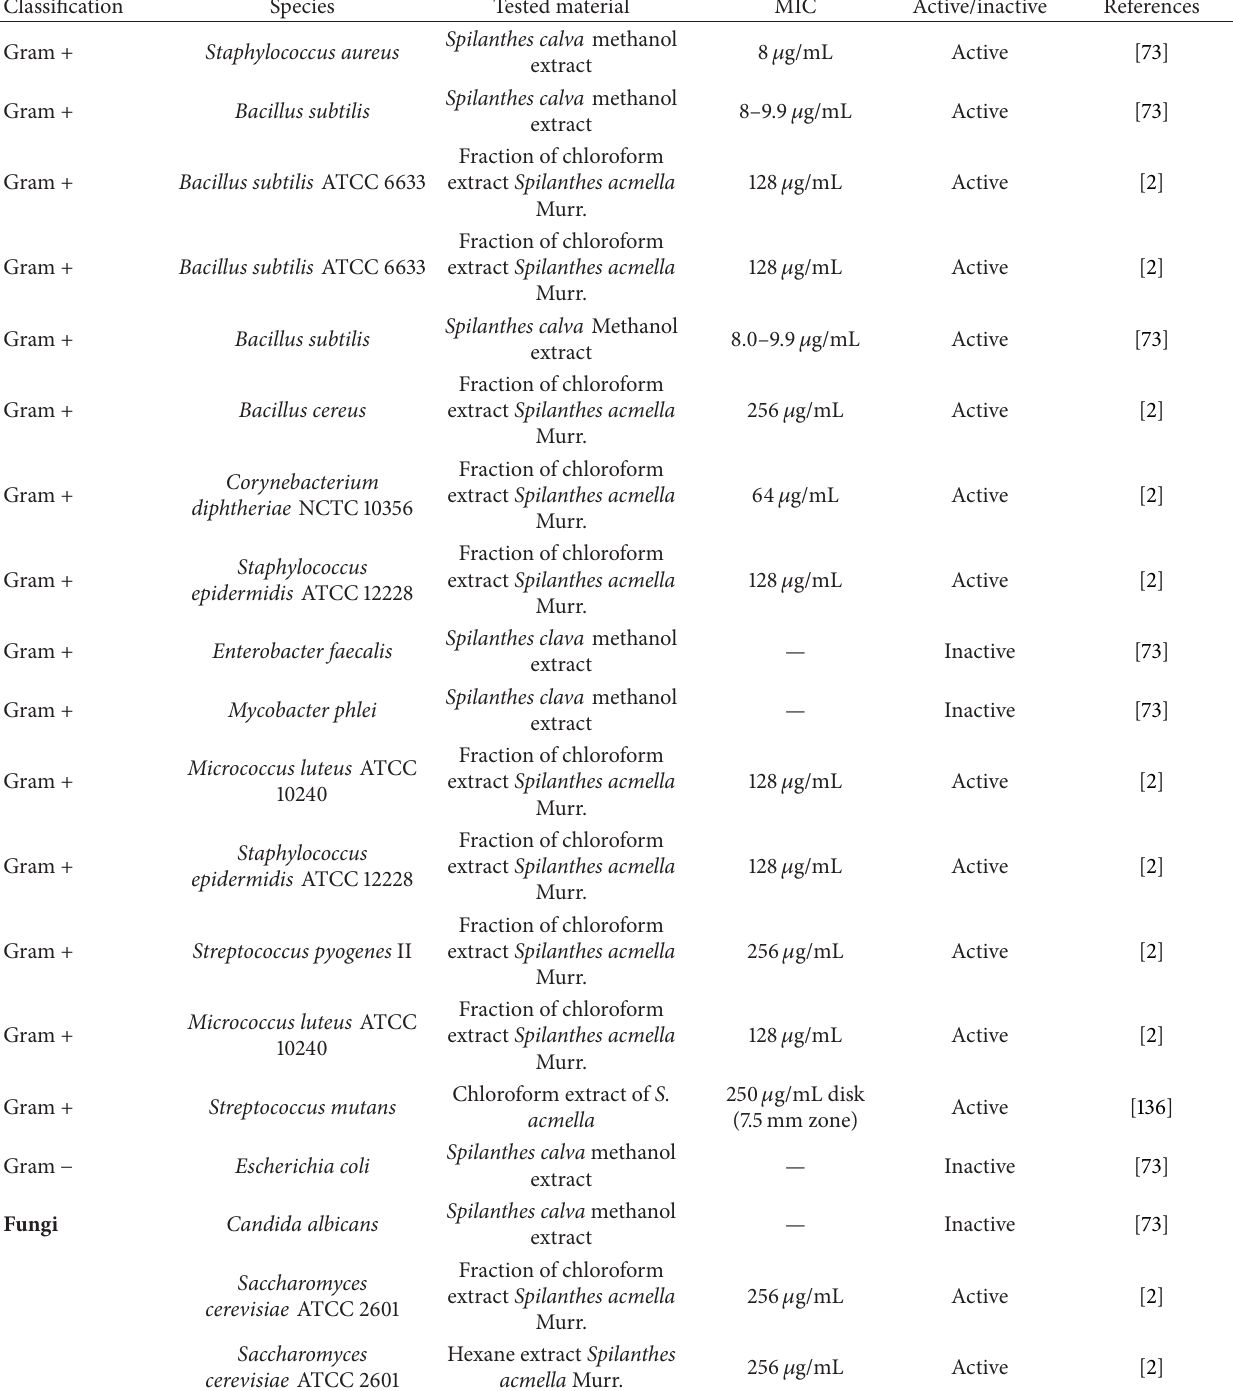
Table 3: Antibacterial and antifungal activities of genus